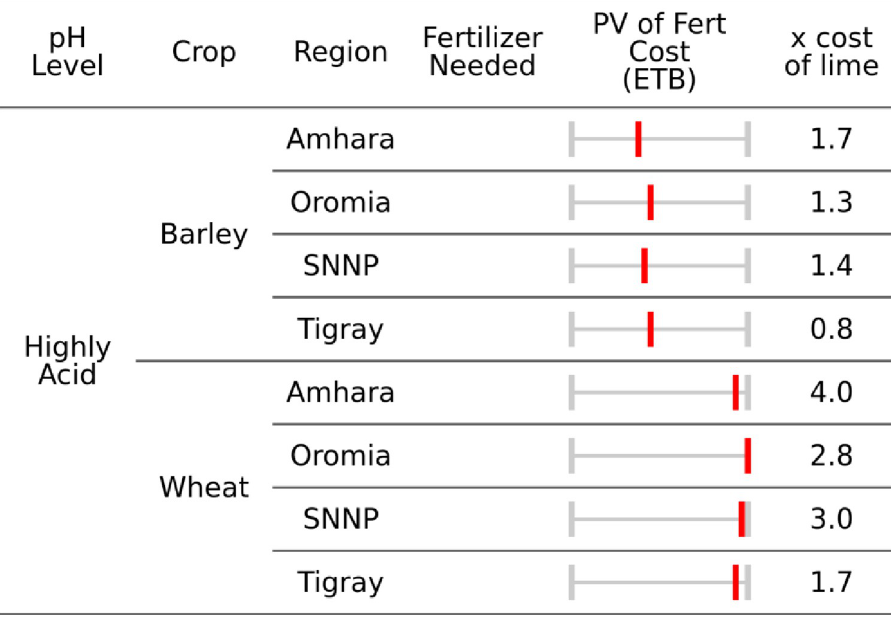
Fig 8. Median regional fertilizer requirements to match lime application (minimum pH of 6.5) for highly acidic